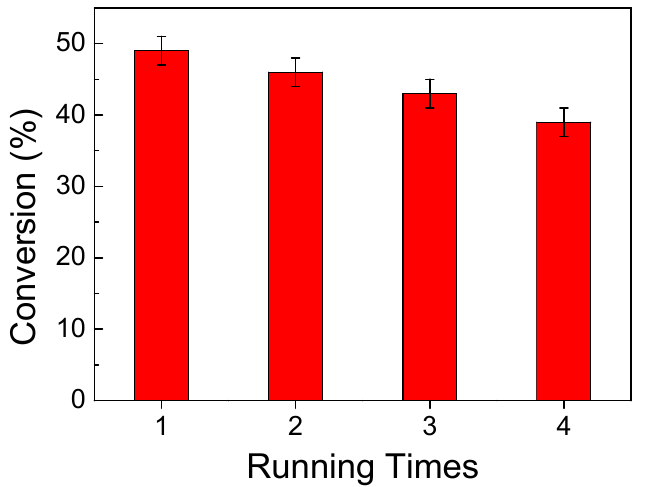
Figure 9. Catalytic recycling performance of (2.5–2.5)VAl-MS-L-cal catalyst to convert substrate 1 in acetonitrile.